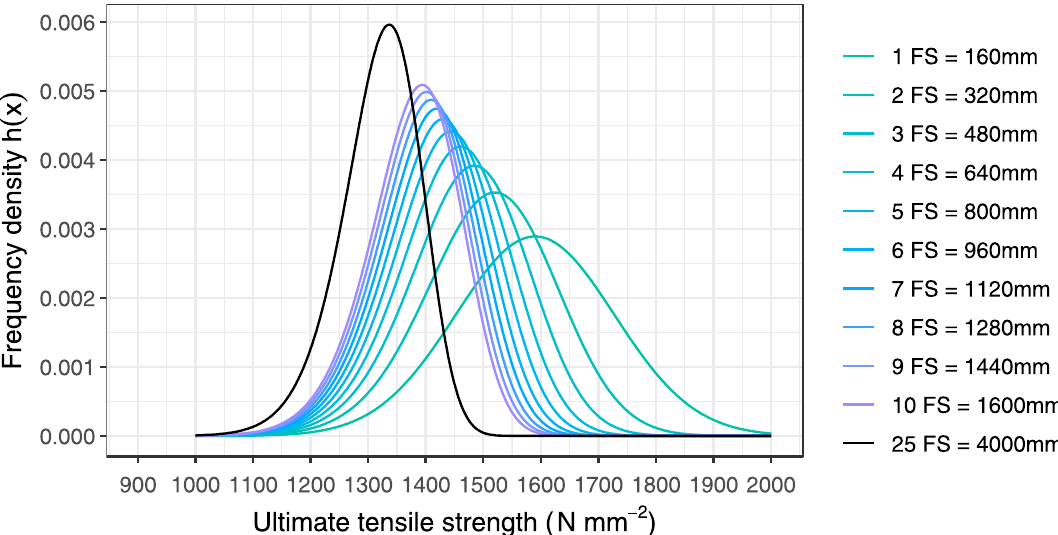
Figure 7. Probability density function of the ultimate tensile strength for a different number of fibre strands (FS) (adapted from 15